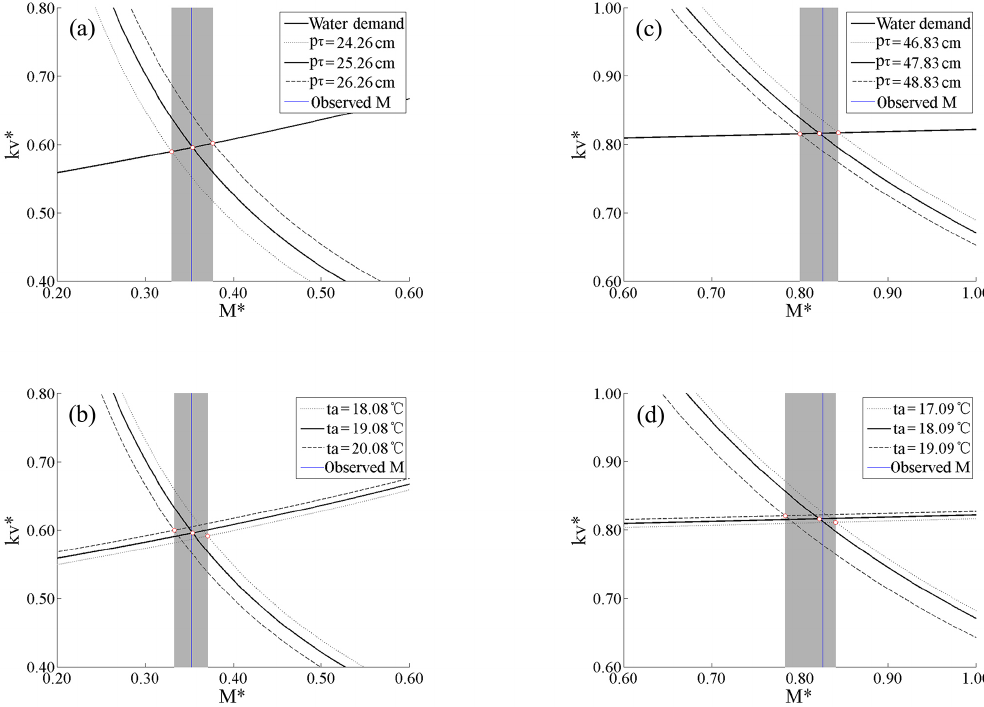
Figure 6. M ∗ changes with precipitation ( P τ ) and air temperature ( t a ): (a, b) grassland; (c, d) forest. The shaded areas indicate the range of M ∗ with the change of vegetation